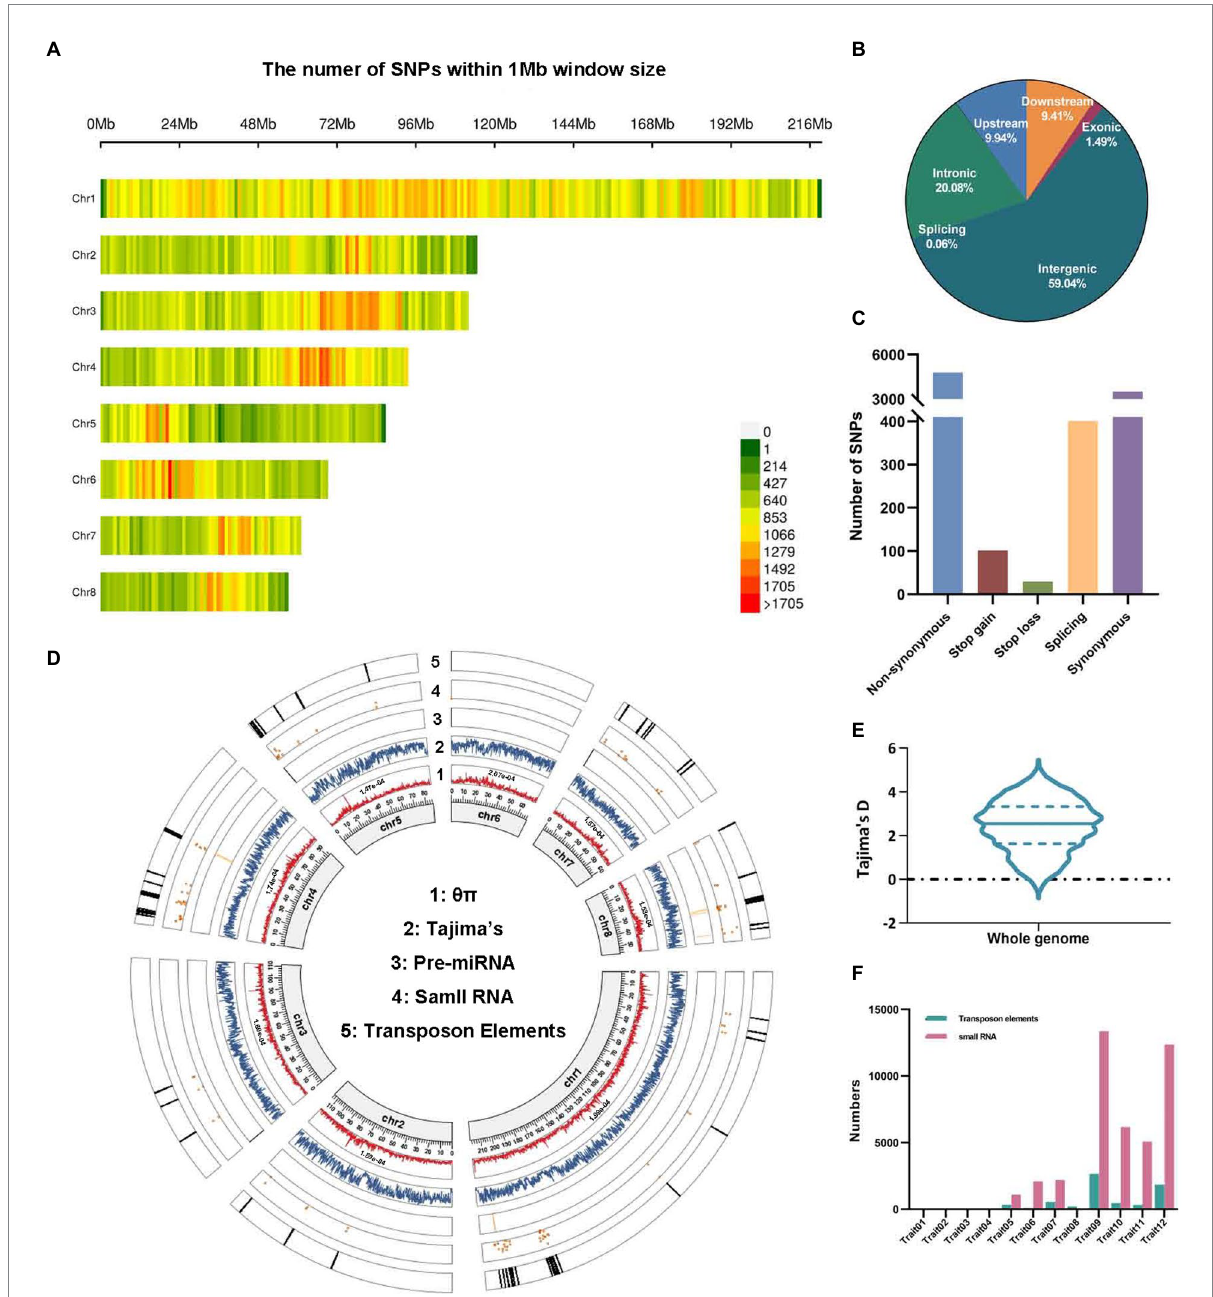
FIGURE 1 The analysis of 455,292 high-quality SNPs in 88 lotus accessions. (A) SNP density across eight chromosomes. (B,C) The genomic distributions (B) and functional annotations (C) of SNPs in 88 lotus accessions. (D) Genetic and genomic features of SNPs on each chromosome are shown in a Circos plot. 1: Mean nucleotide diversity ( θπ ). 2: Tajima’s D. 3–5: The distribution patterns of known pre-miRNA, small RNA (sRNA) and transposon elements (TEs) significantly linked to SNPs from other studies. (E) Tajima’s D values across the whole genome. (F) The proportion of sRNA and TEs associated with 12 traits in 88 lotus